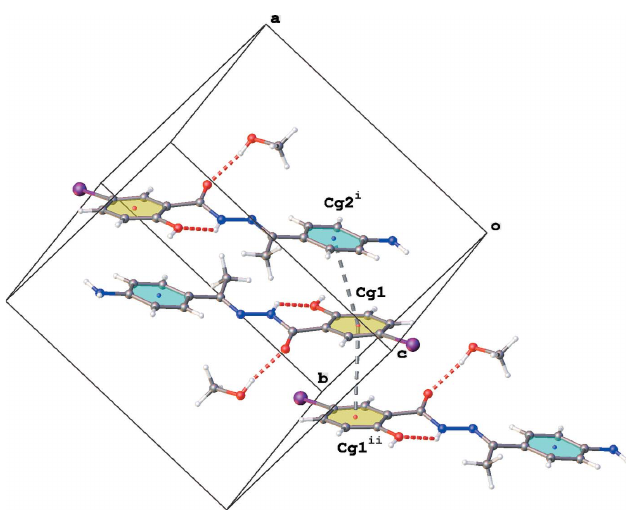
Figure 4 Part of the crystal packing of the title compound, showing the (cid:2) – (cid:2) stacking interactions between the aminophenyl (blue) and iodophenyl (yellow) rings [symmetry codes: (i) (cid:4) x + 1, (cid:4) y + 1, (cid:4) z + 1; (ii) (cid:4) x , (cid:4) y + 1, (cid:4) z + 1].